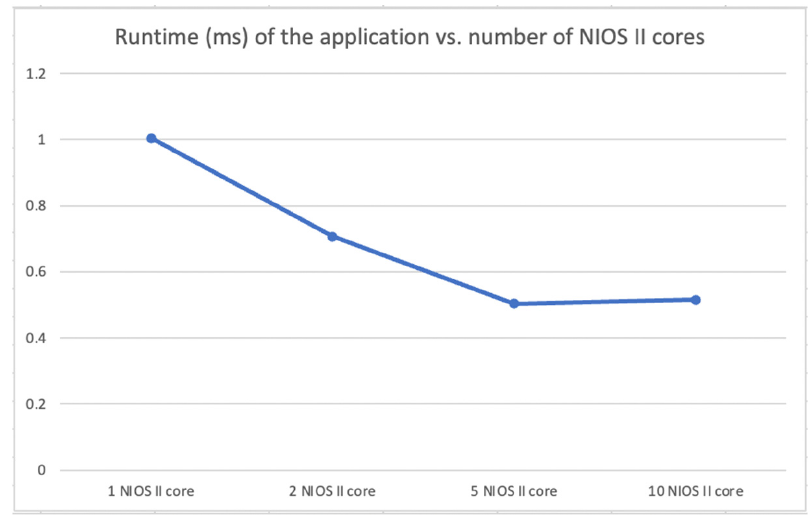
Figure 20. A diagram of the runtime of the application vs. number of NIOS II cores.